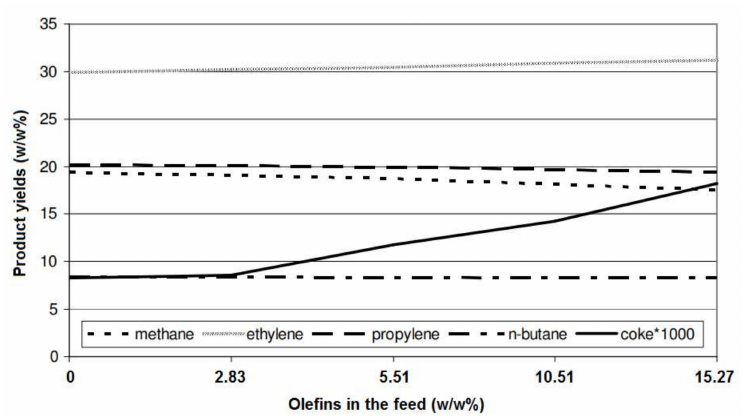
Figure 11. Effect of the olefin concentration in the feedstock on product yields